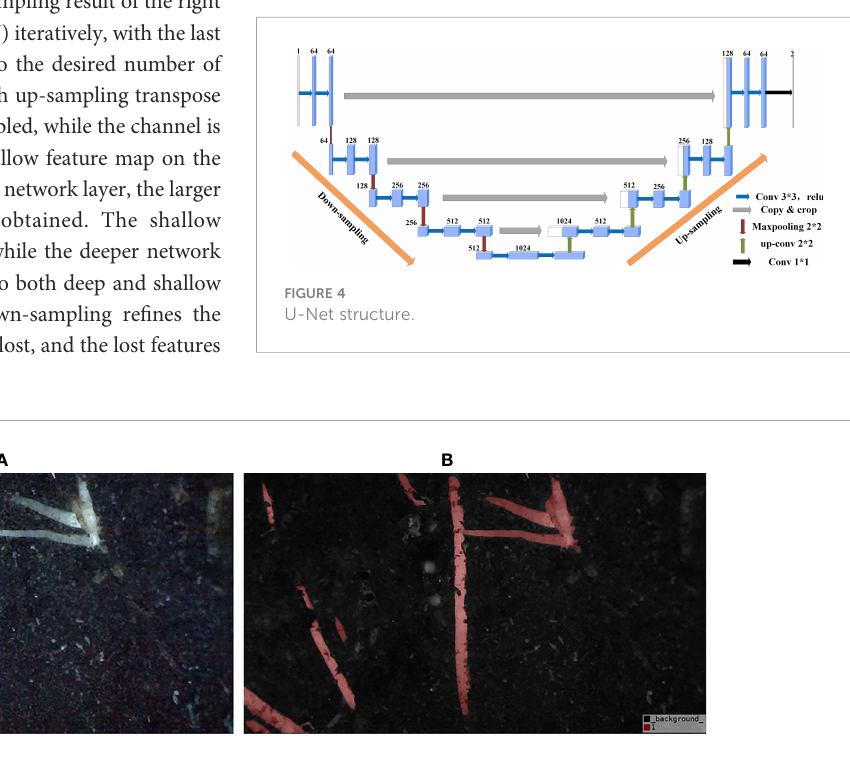
FIGURE 3 Image annotation map. (A) Photographs of the root system, (B) Sample of annotated image.